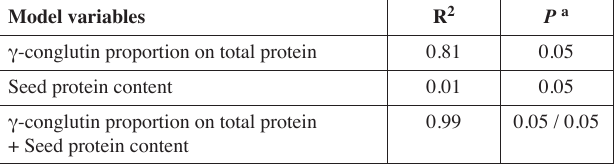
a P level significance of explanatory variables in the